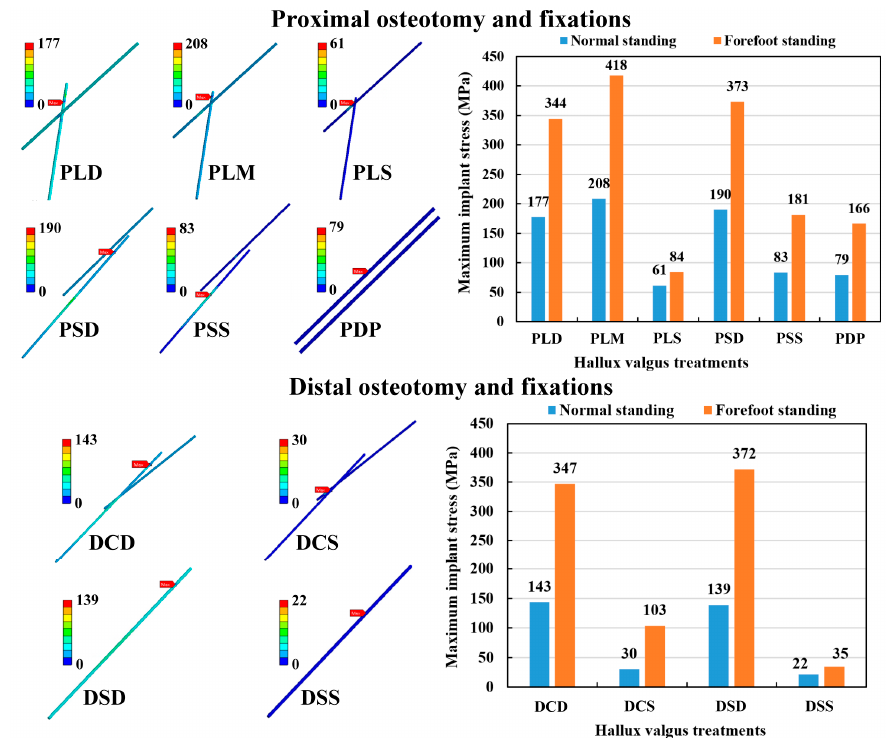
Figure 8. The implant stress distribution of the numerical models and the results of the maximum Kirschner wire stress.